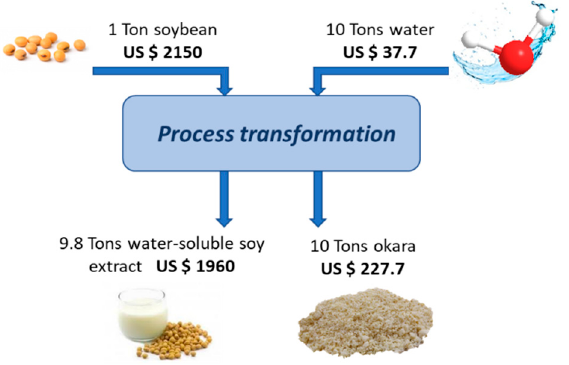
Figure 4. Costs (US $ / Ton) of the production processes of water-soluble SB extract (soymilk) and okara (data from Guimarães et al.) [126].